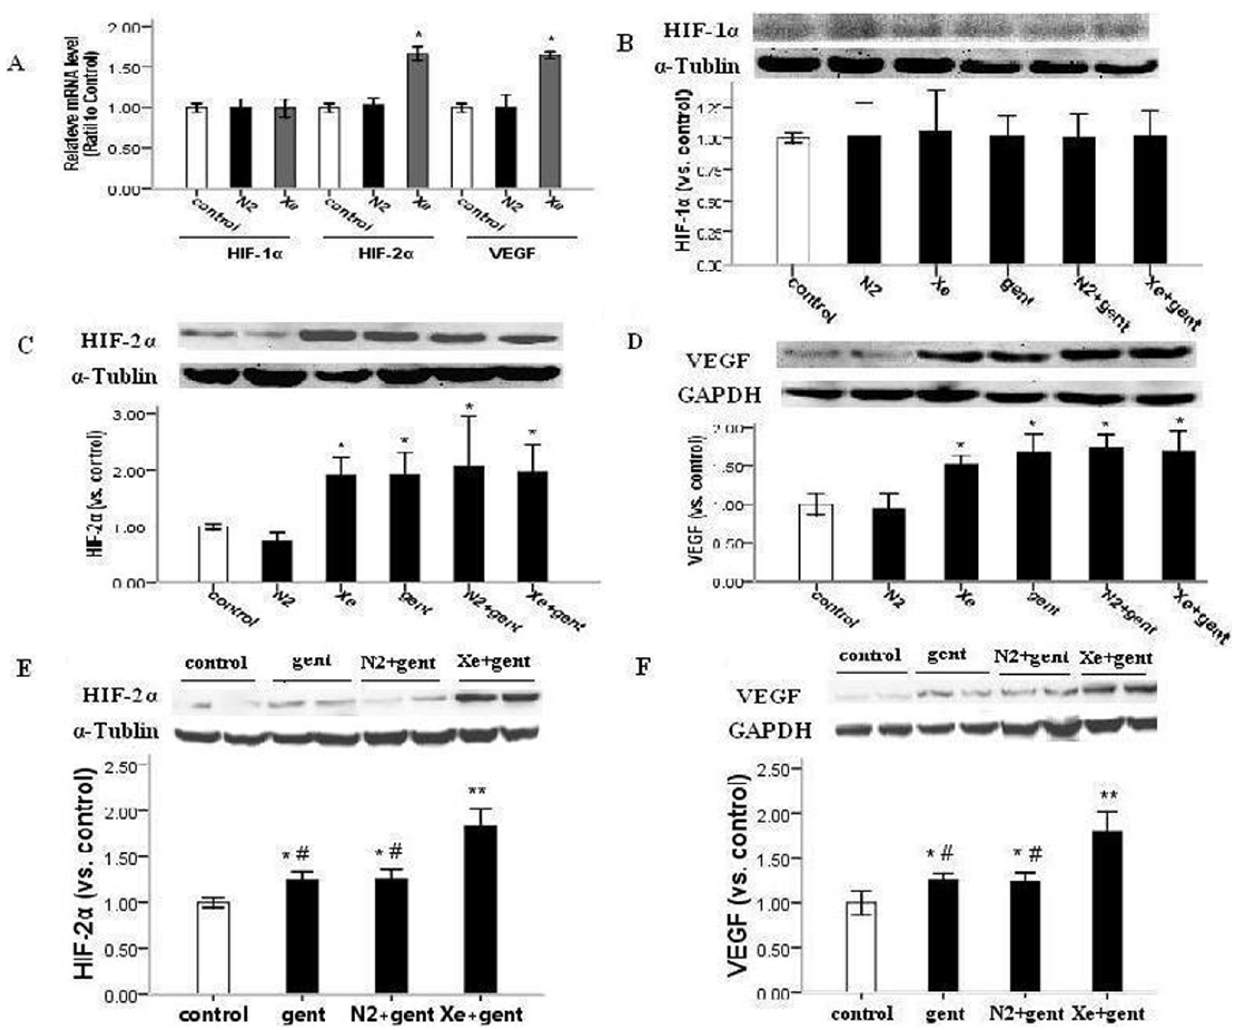
Figure 5. Xe pretreatment up-regulated HIF-2 a and VEGF, but not HIF-1 a . A: the relative mRNA levels of HIF-1 a , HIF-2 a and VEGF by real- time reverse transcriptase-PCR analysis from N 2 group and Xe group 24 hrs after N 2 or Xe pretreatment alone. Xe upregulated the mRNA level of HIF- 2 a and VEGF, but not HIF-1 a . B–F: representative images of western blot analysis of HIF-1 a , HIF-2 a and VEGF from N 2 group and Xe group 24 hrs after N 2 or Xe pretreatment alone, and from gentamicin group, N 2 + gentamicin group, Xe + gentamicin group and control 48 hrs or 4 days after 7-day gentamicin administration. Relative intensities of HIF-1 a , HIF-2 a and VEGF blots normalized to control. B: Xe or N 2 pretreatment or gentamicin administration did not affect HIF-1 a . 24 hrs after N 2 or Xe pretreatment alone or 48 hrs after 7-day gentamicin administration. HIF-1 a barely detectable level in all groups. C-D: Xe pretreatment or gentamicin treatment significantly up-regulated HIF-2 a and VEGF 24 hrs after Xe pretreatment alone or 48 hrs after 7-day gentamicin administration. E-F: Xe + gentamicin group significantly up-regulated HIF-2 a and VEGF 4 days after 7-day gentamicin administration. *P , 0.05, **P , 0.01 vs. control group, # P , 0.05 vs Xe + gentamicin group,